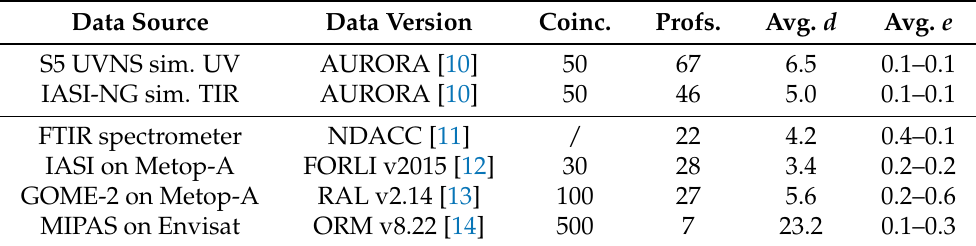
Table 2. Data specifications for the six demonstrative datasets (April 2012): data source, data version, maximum co-location distance from Izaña (in km), number of co-located profiles, average number of independent degrees of freedom d , and average retrieval error e around the ozone maximum and in the troposphere (in 10 12 molecules/cm 3 ). Top two rows specify simulated data for the Metop-SG-A1 UVNS and IASI-NG instruments; bottom four rows specify real observations acquired by the NDACC FTIR instrument operating at Izaña and by three different satellite